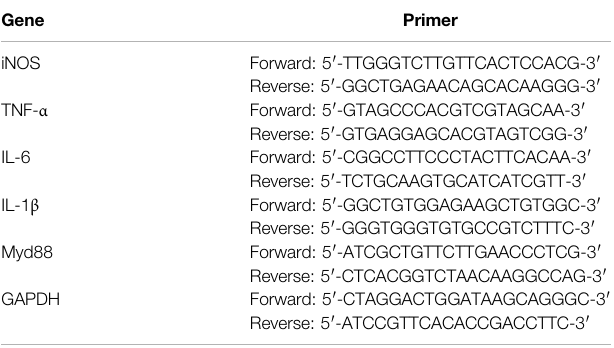
TABLE 1 | Speci fi c primers for